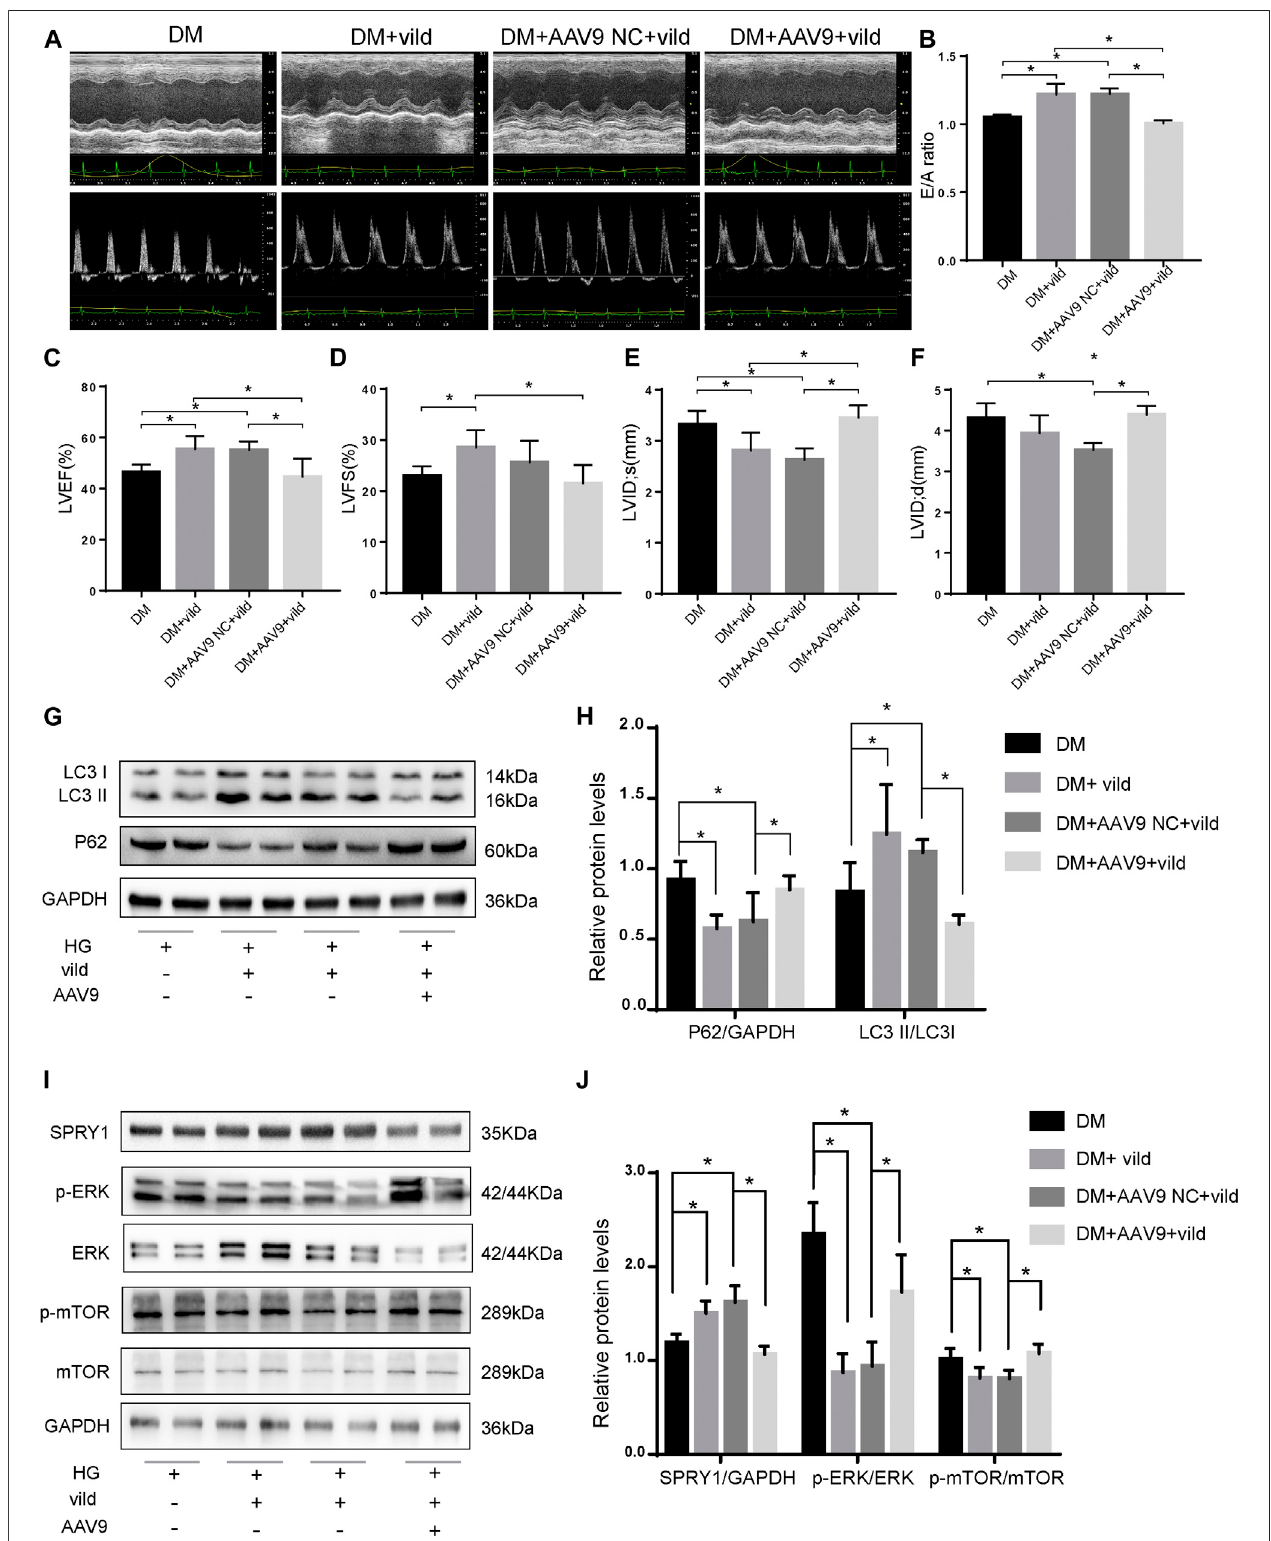
FIGURE 6 | Vild prevents DCM and autophagy by regulating the miR-21/SPRY1/ERK/mTOR pathway. (A) M-mode echocardiograms and pulse-wave Doppler